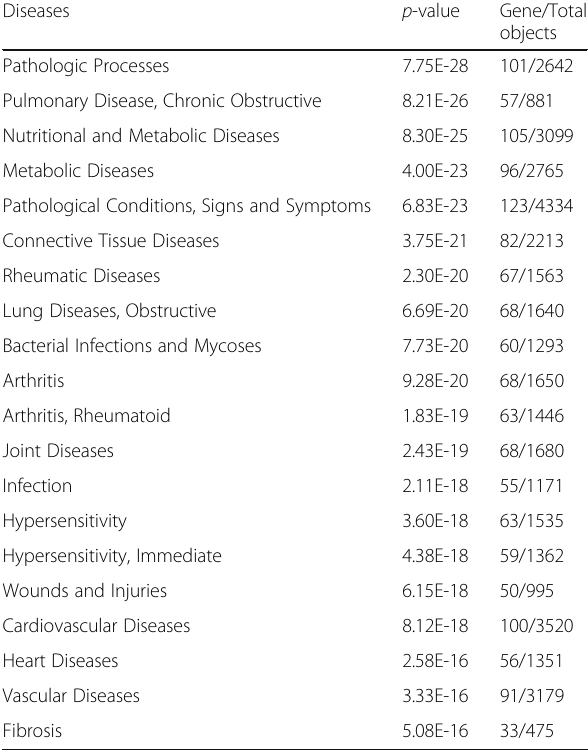
Table 2 Top 20 diseases affected by EA stimulation at ST36 in